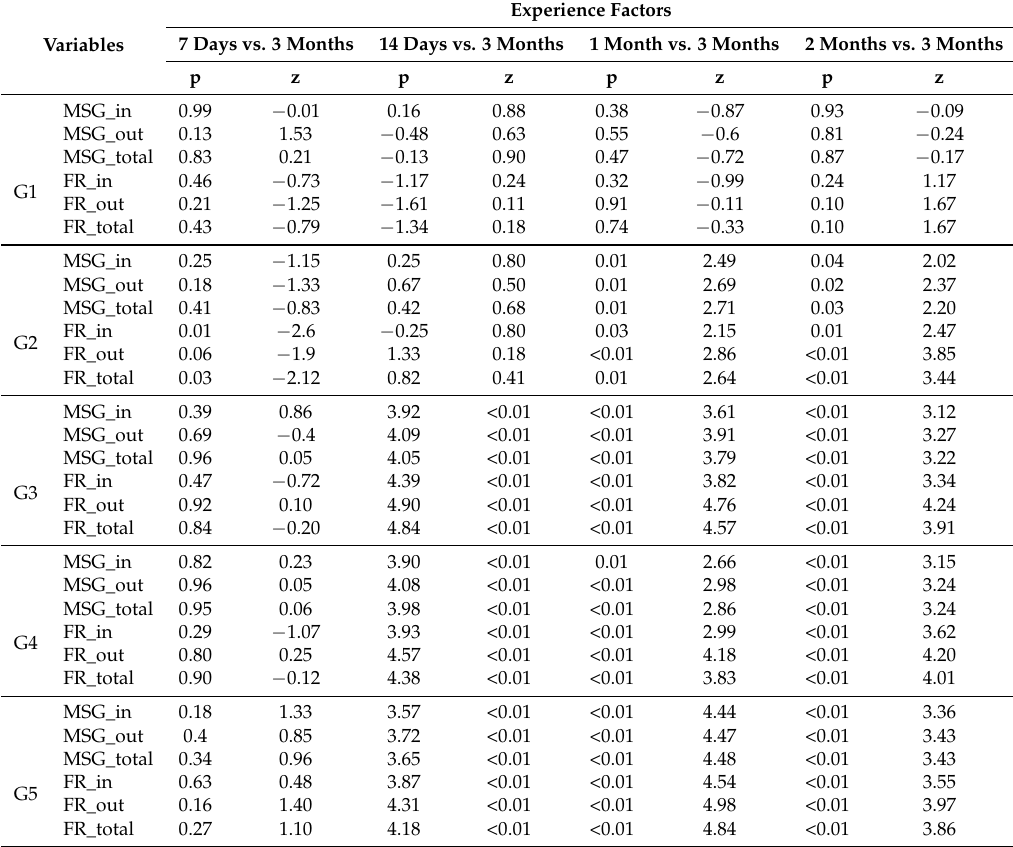
Table A2. Intergroup comparisons using the life-length of a product as a dependent variable and as non-variable